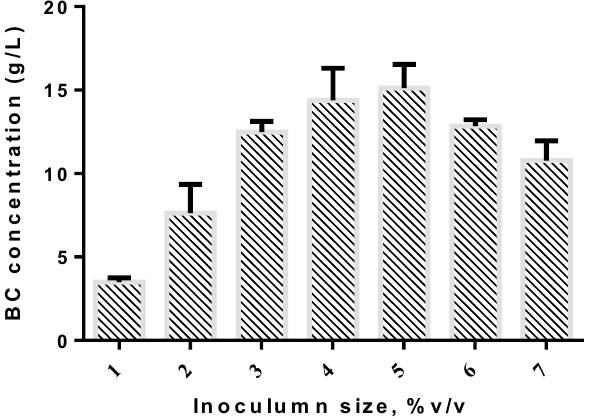
Figure 5. Effect of inoculum size on the production of BC using immobilized cells in biofilm fermentation (Fermentation time = 15 day; initial pH = 5.5; shaking condition).